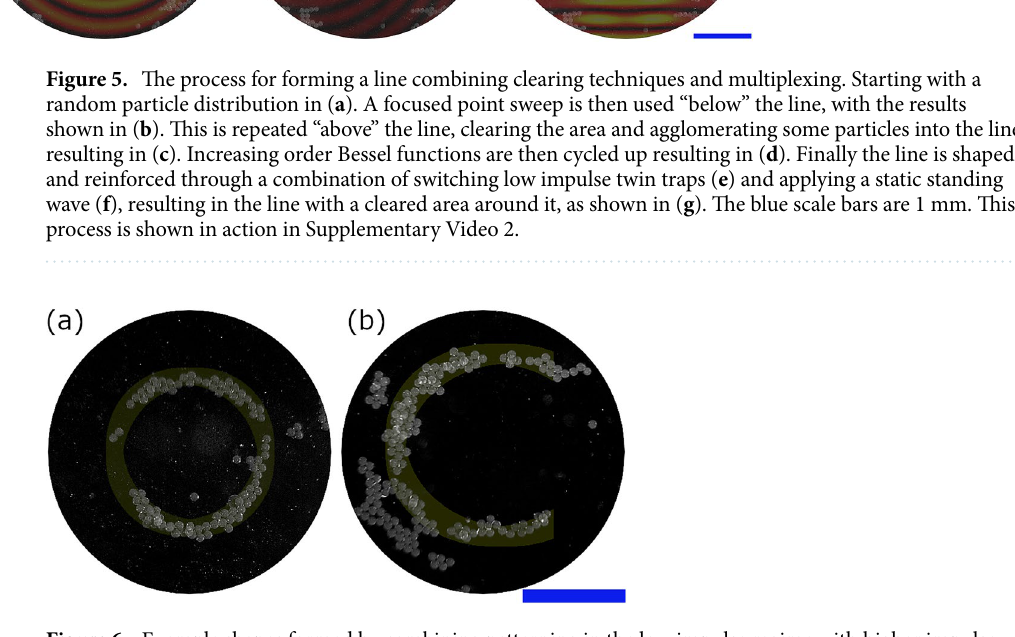
Figure 6. Example shapes formed by combining patterning in the low impulse regime with higher impulse clearing operations. ( a ) shows a circle formed by switching between states consisting of a 5th and 9th order Bessel-shaped field. ( b ) shows an C-shape formed by a collection of twin traps The blue scale bar is 1 mm. For forming of ( a ) see Supplementary Video